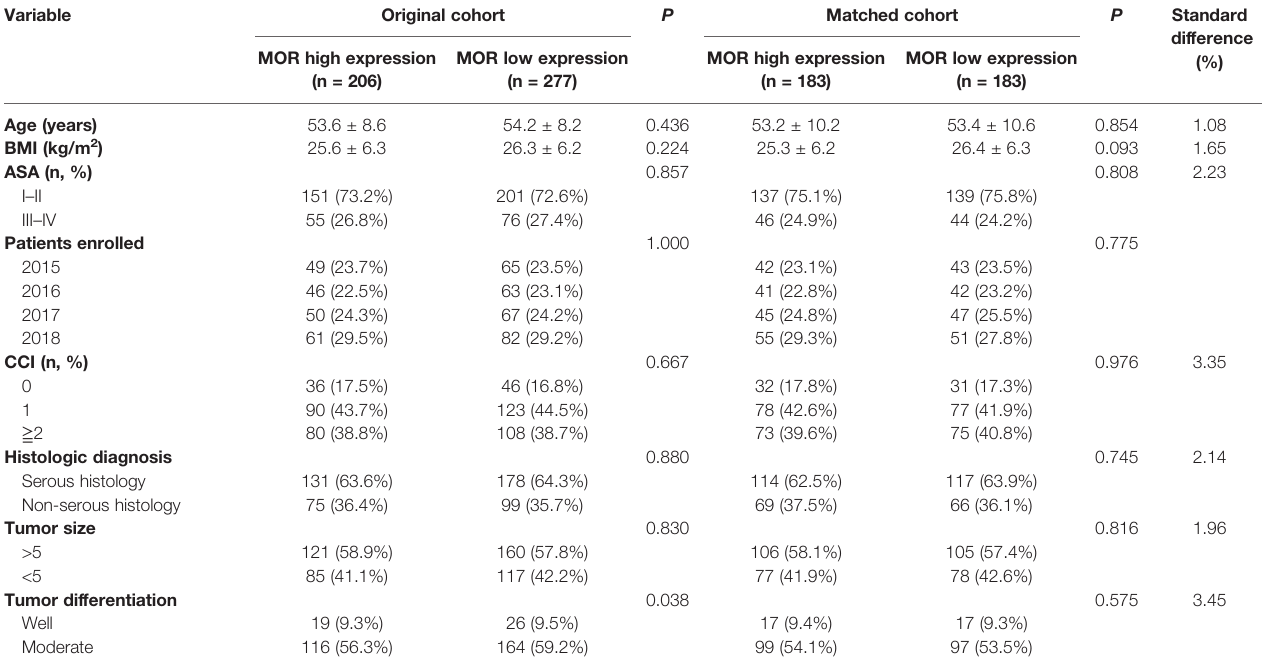
TABLE 1 | Patient and treatment characteristics for both groups. Variable Original